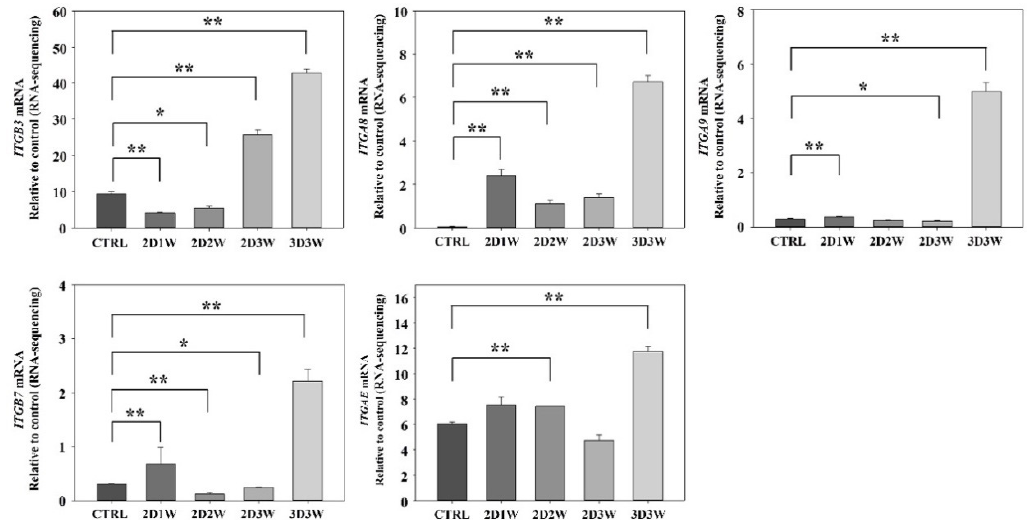
Figure 6. Five integrin gene expressions in RNA-Seq data. Integrin genes known to be related to osteogenic differentiation were selected and are described in the discussion section. * p < 0.1, ** p < 0.05 vs control value.